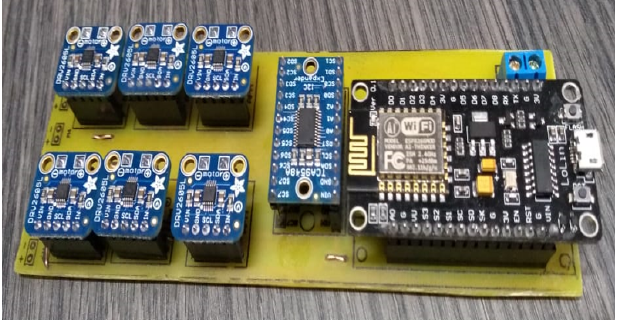
Figure 8. Haptic glove control